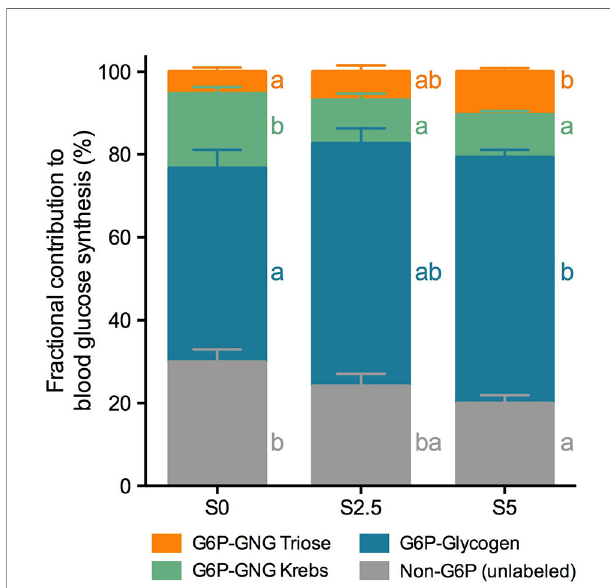
FIGURE 6 | Fractional contribution to blood glucose synthesis of European seabass ( Dicentrarchus labrax ) fed with different levels of glycerol (0, 2.5, and 5%) for 6 weeks. Contributions are represented as percentage of total (%). Values are mean ± SEM (n = 12). Signi fi cant differences are indicated by different letters (one- way ANOVA; followed by Tukey for p < 0.05; ns, not signi fi cant). The color scheme corresponds to metabolic pathways depicted in Figure 1 .